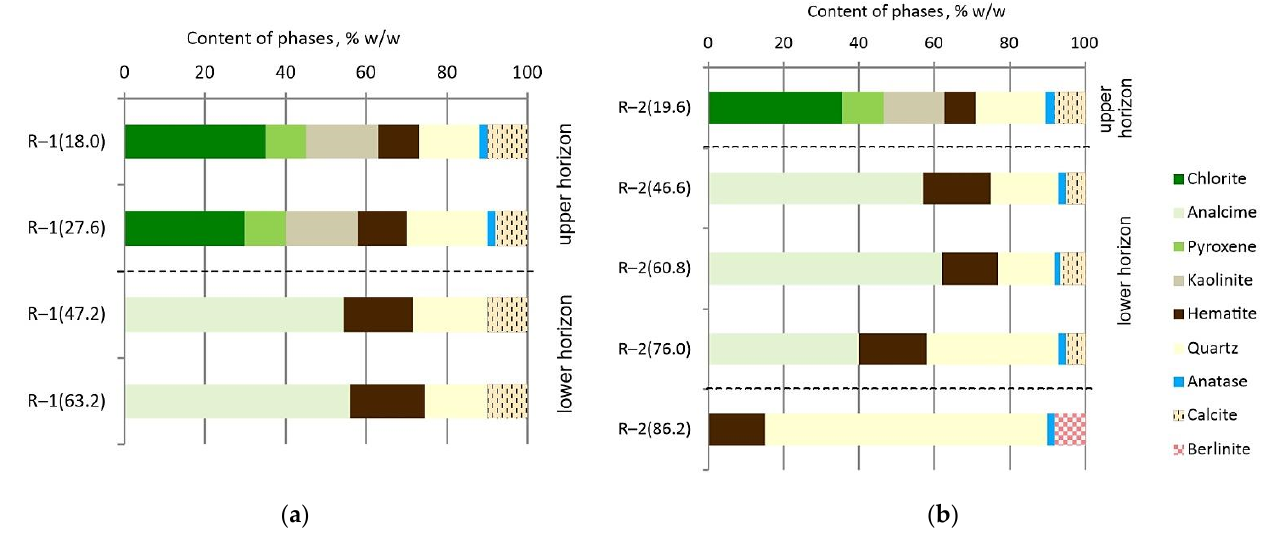
Figure 7. Mineral composition of volcanic tuff core samples from Radoshivka–1 well ( a ) and Radoshivka–2 well ( b ).